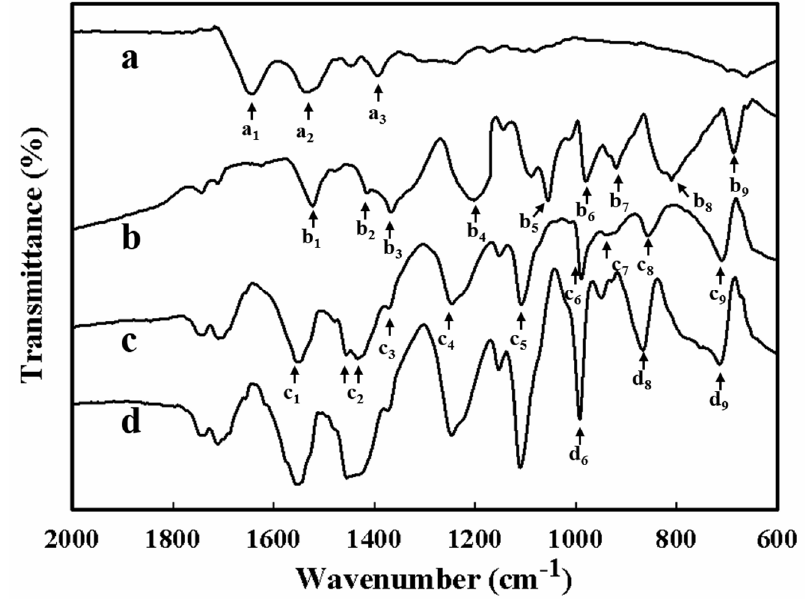
Figure 4. The FTIR spectra for (a) BSA, (b) PEDOT/Pt, (c) PEDOT:BSA/Pt, and (d) AuNPs/PEDOT:BSA/Pt.